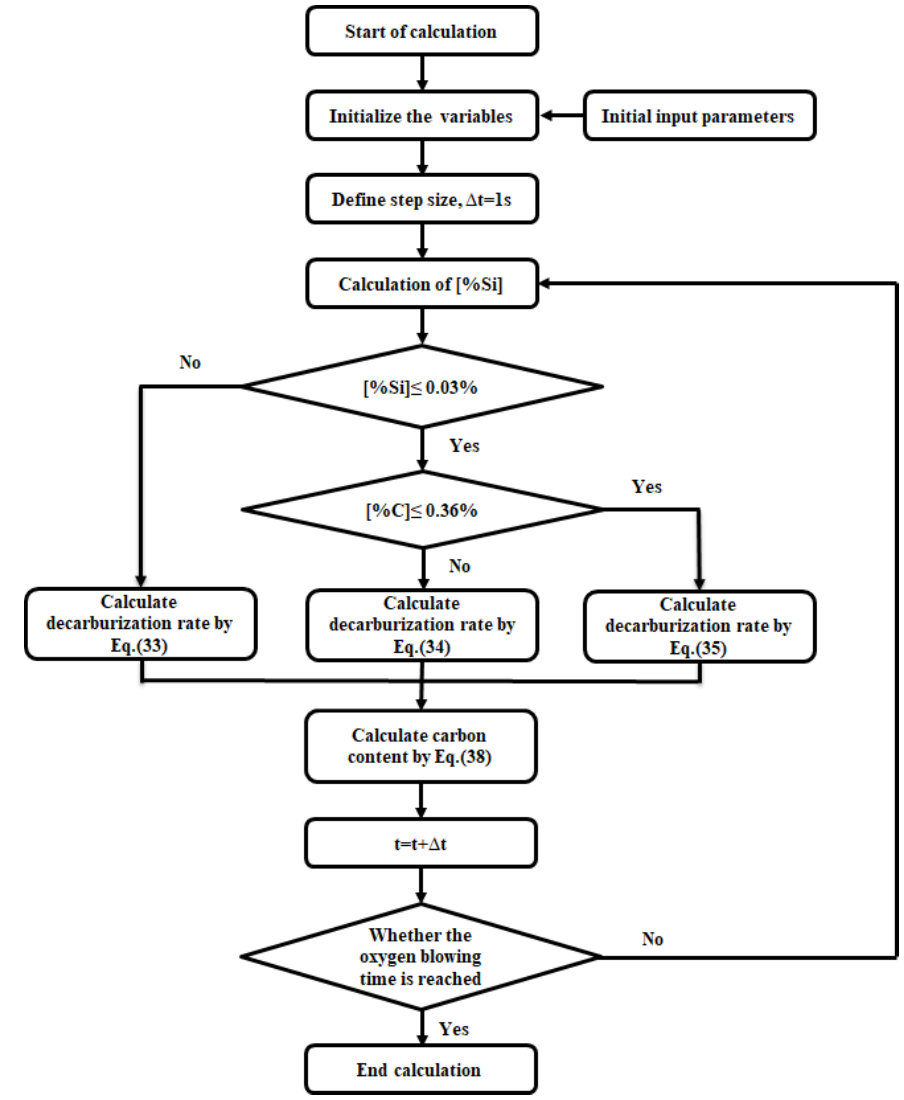
Figure 5. Calculation flow chart of the continuous prediction model of carbon content. According to the explicit finite difference method, the carbon content at (t + ∆ t) is calculated by Equations (33) – (38).